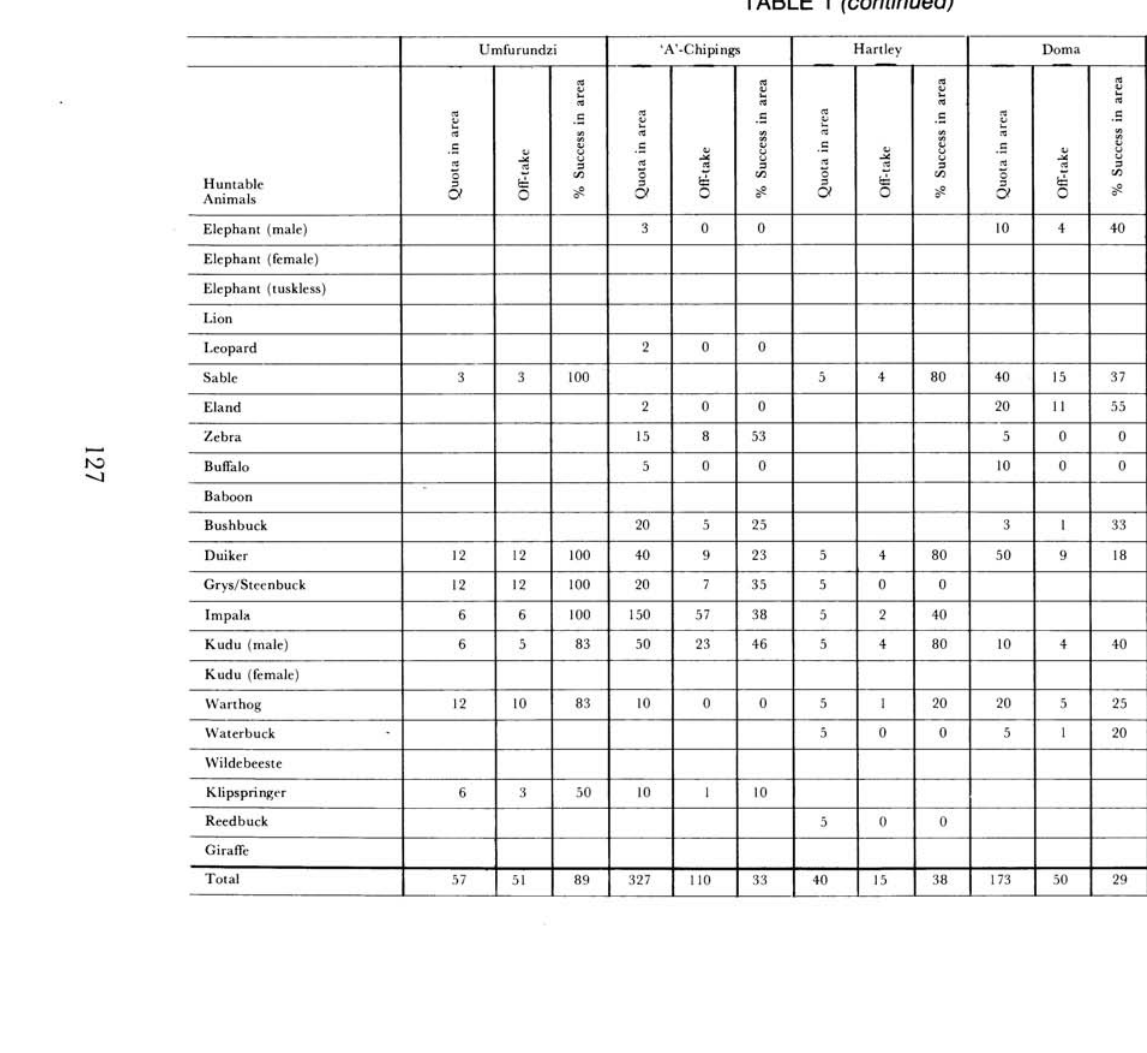
Humablc Animals Elephant (male) Elephant (female) Elephant (tuskless) Lion Leopard Sable Eland Zebra Buffalo Baboon Bushbuck Duiker Grys/Stccnbuck Impala Kudu (male) Kudu (female) Wan hog Waterbuck Wildebeeste KlipspringC'f Reedbuck Giraffe Total